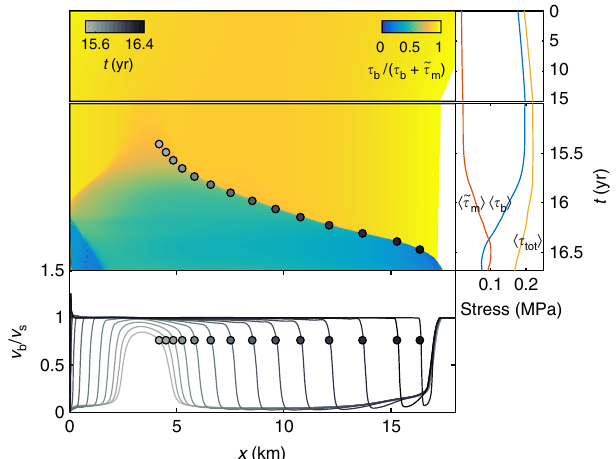
Fig. 3 Stress is transferred from the base to the margins during the surge. The velocity at the base becomes approximately equal to the velocity at the surface behind the surge front. The main panel shows the fraction of spatiotemporal shear stress τ b , supported by the base. ~ τ stress from the margins calculated by Supplementary equation 16. The right panel shows the average basal shear stress 〈 τ b 〉 , margin stress h ~ τ average driving stress 〈 τ tot 〉 as a function of time. There is a gradual build- up of stress before the surge starts around t = 15.5 years. During the surge, stress is transferred from the base to the margins, and the driving stress decreases. The bottom panel shows the ratio of basal and surface velocity for different instances in time during the surge. The grayscale dots correspond to the grayscale dots in the main panel and are uniformly spaced in time with intervals of 30 days. Behind the surge front, the basal and surface velocities are more or less equal. The simulation in the fi gure used d c = 1.0 m, q =